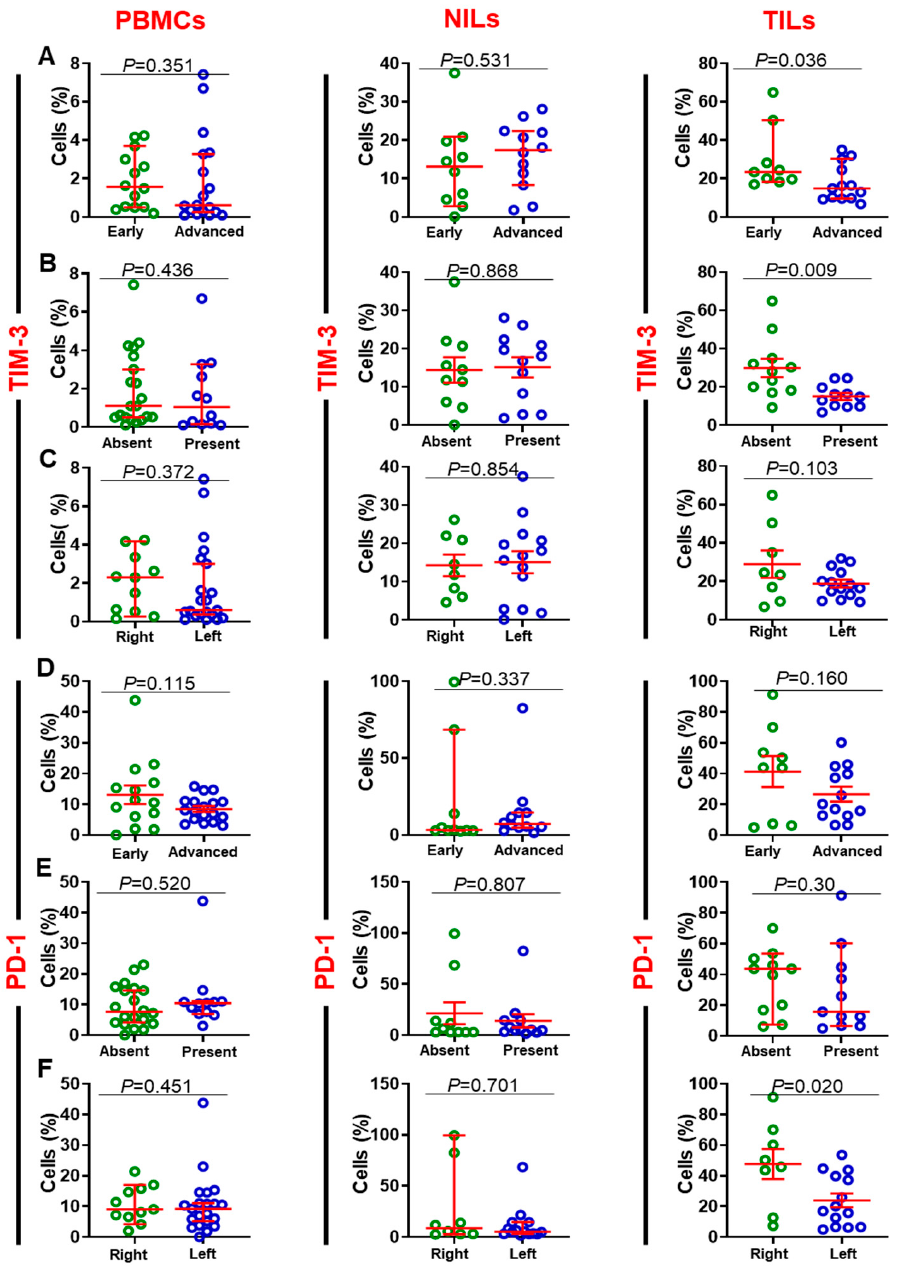
Figure 3. Comparison of TIM-3 and PD-1 expression on CD3 + CD4 − T cells in PBMCs, TILs and NILs. CRC patients were grouped based on disease stages (early; stage I/II and advanced; stage III/IV), anatomical location (right-sided and left-sided) and absent/present LVI. Scatter plots present the differences in the levels of TIM-3-expressing cells in early and advanced stages ( A ), absent/present LVI ( B ), right-sided and left-sided tumors ( C ), and levels of PD-1 in early and advanced stages ( D ), absent/present LVI ( E ), and right-sided and left-sided tumors ( F ) in PBMCs, NILs, and